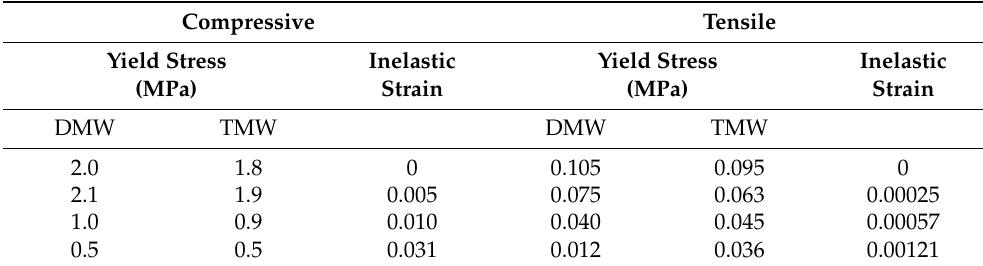
Table 4. Data points assigned for the nonlinear behavior of the CDP